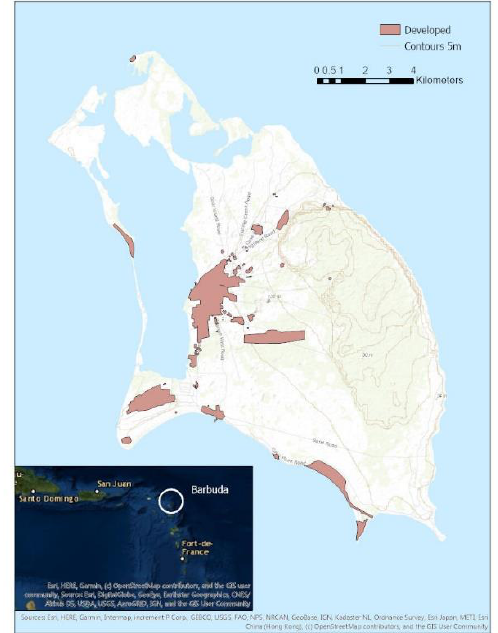
Figure 2: Location of Barbuda along the chain of islands that form the Lesser Antilles. The highest elevations on Barbuda are along the eastern side.